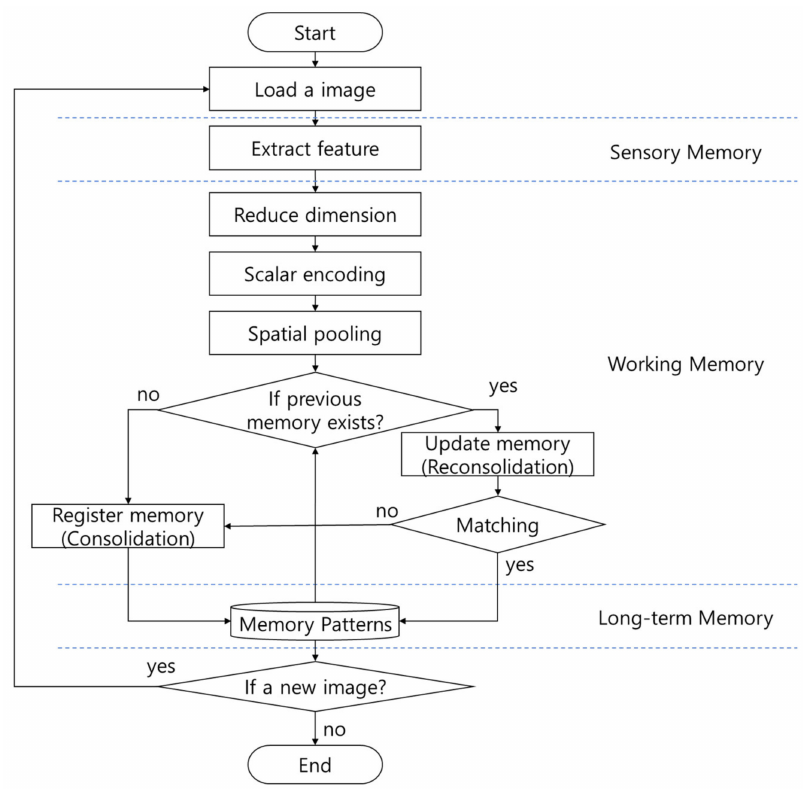
Figure 8. Memory model remembering the morphological semantics of visual